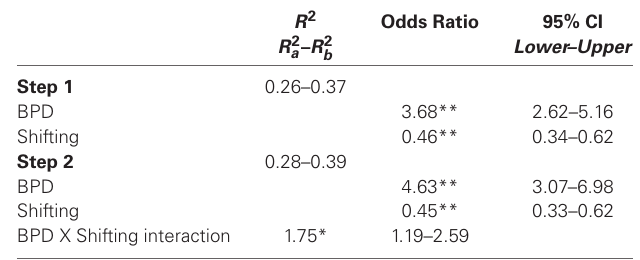
Table 5 | Hierarchical Logistic Regression testing interaction effects of BPD features and shifting on prior incidence of self-harm .